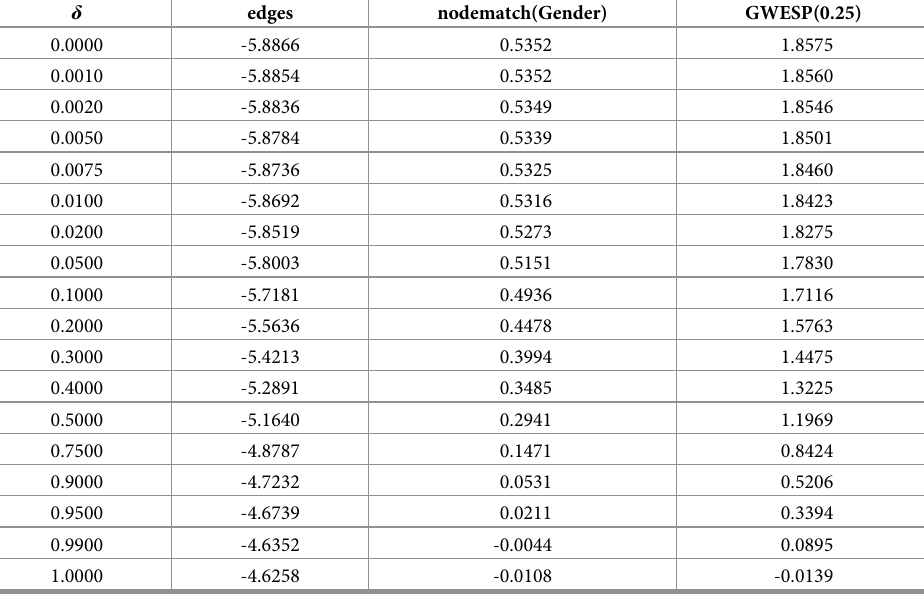
Table 2. Mean MAP estimates of model parameters under different relative prior weights when m = 1. (Data gener- ating parameters θ